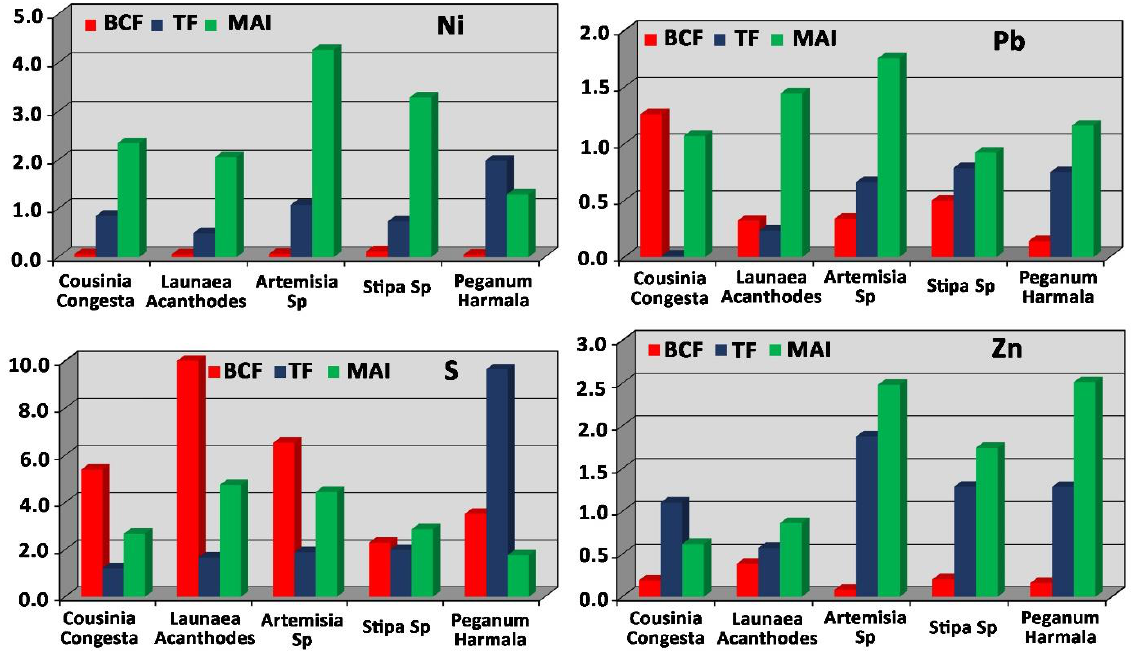
Figure 7. The BCF, TF, and MAI factors for Zn, S, Pb, and Ni in the native plant species.